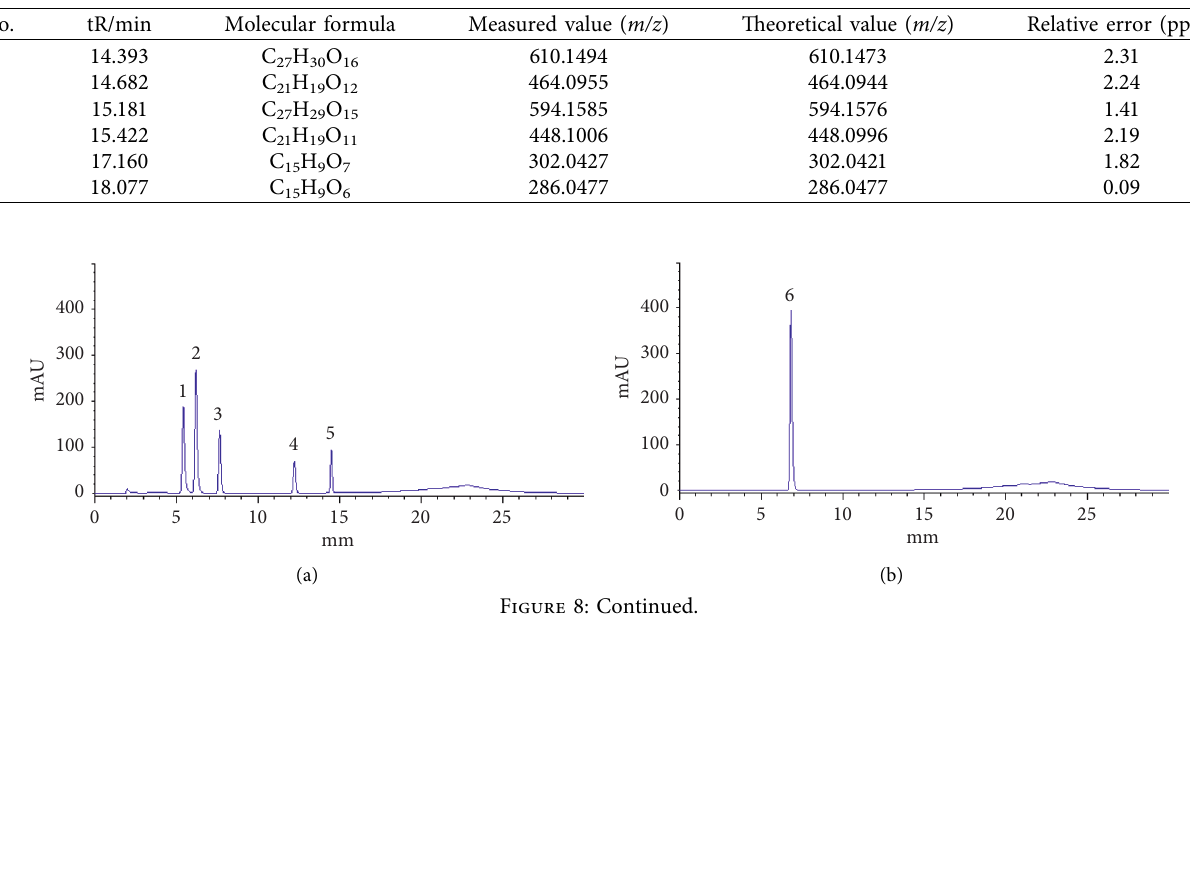
Figure 7: Mass chromatogram of components in EAE (4mg/mL). (a) Mass chromatogram of rutin. (b) Mass chromatogram of isoquercetin. (c) Mass chromatogram of kaempferol-3-o-rutoside. (d) Mass chromatogram of astragaloside. (e) Mass chromatogram of quercetin. (f) Mass chromatogram of kaempferol. Table 1: Molecular weight and formula of six chemical components in EAE (4mg/mL).